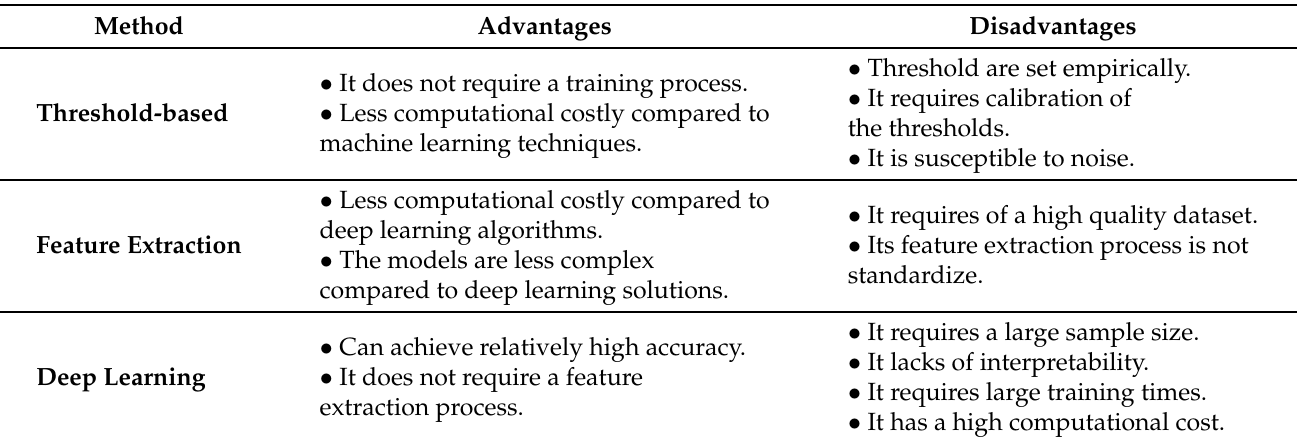
Table 9. Advantages and disadvantages of road anomaly detection and classification systems through vibration-based